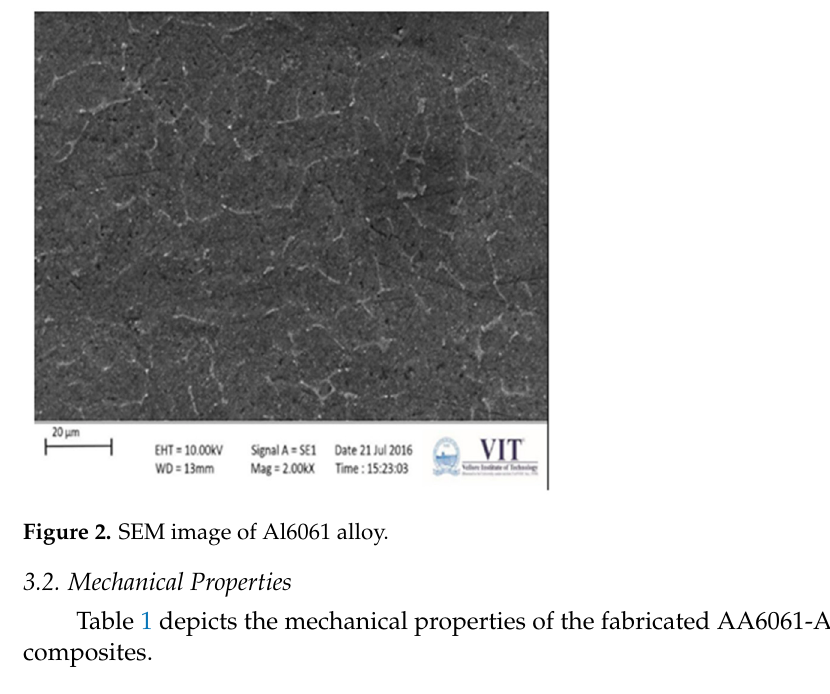
Table 1. Mechanical properties of the AA6061-Al 2 O 3 -grpahene composites.